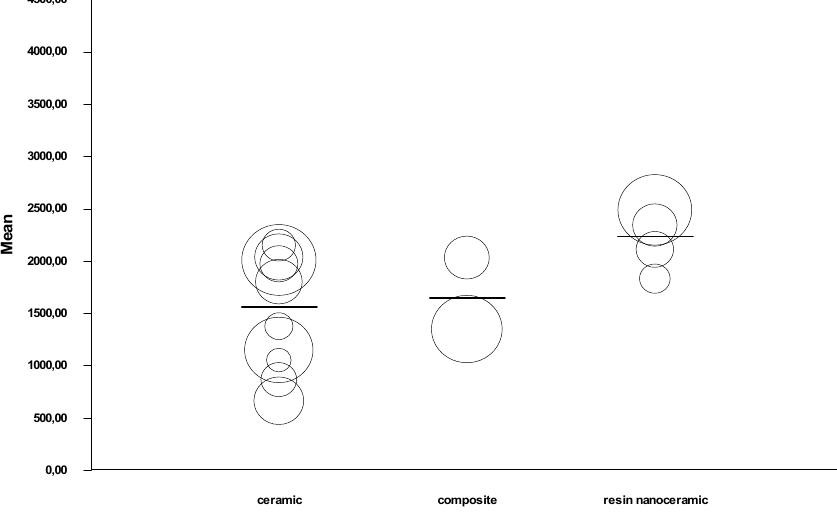
Figure 7. Regression model of fracture resistance by material.